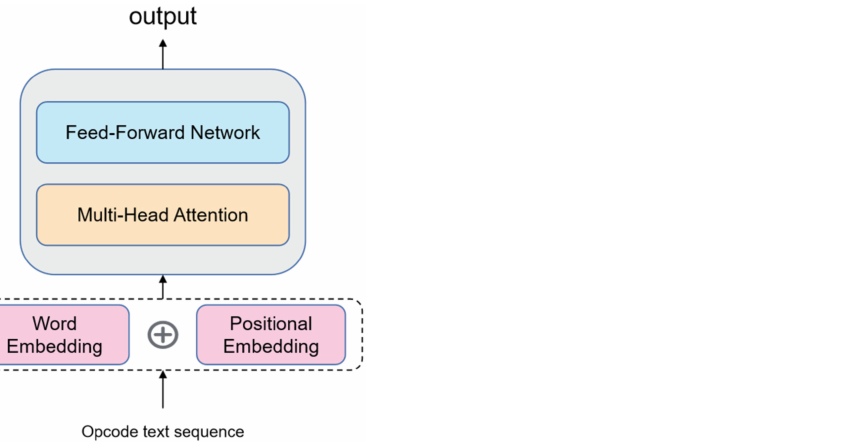
Figure 8. The bottom shared layer design framework, including word embedding, positional embed- ding, multi-head attention layer, and feed-forward